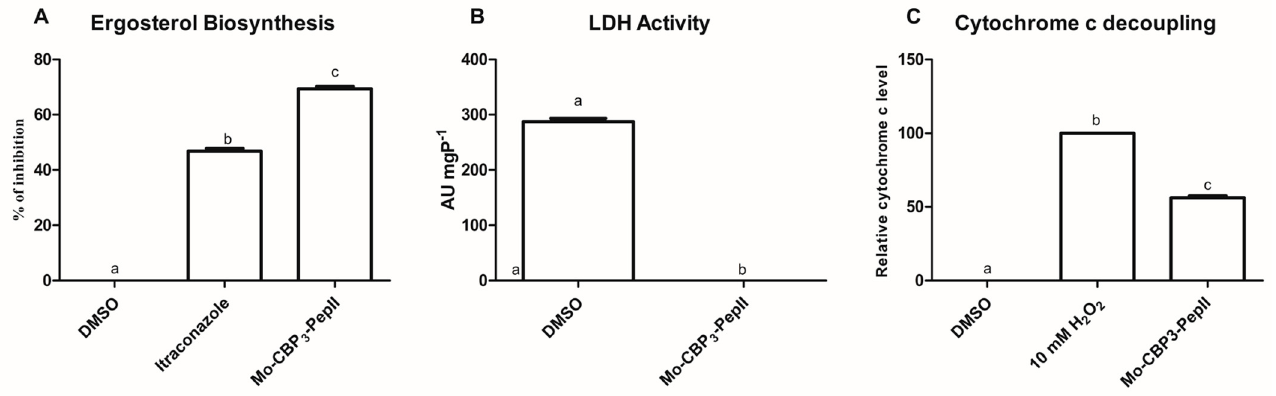
Figure 4 . Mo-CBP 3 -PepII interferes with vital cellular processes for C. neoformans cells. ( A ) inhibition of the biosynthesis of ergosterol, ( B ) lactate dehydrogenase activity, and ( C ) release of Cyt c from the mitochondrial membrane. The different lowercase letters in (graphic) indicate statistical significance at p > 0.05.